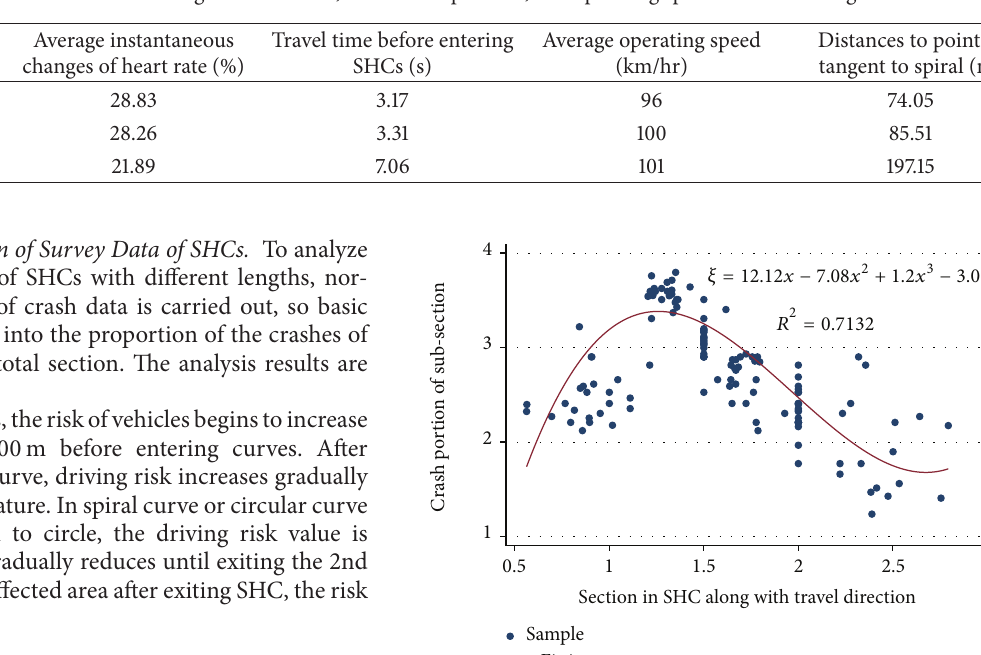
Figure 5: Driving risk distribution of SHCs along with travel